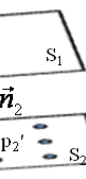
Figure 9. Plane Projection Image of viewpoint #2, Top Left: When the plane of interest is P e , Top Right: P g , Bottom: P f